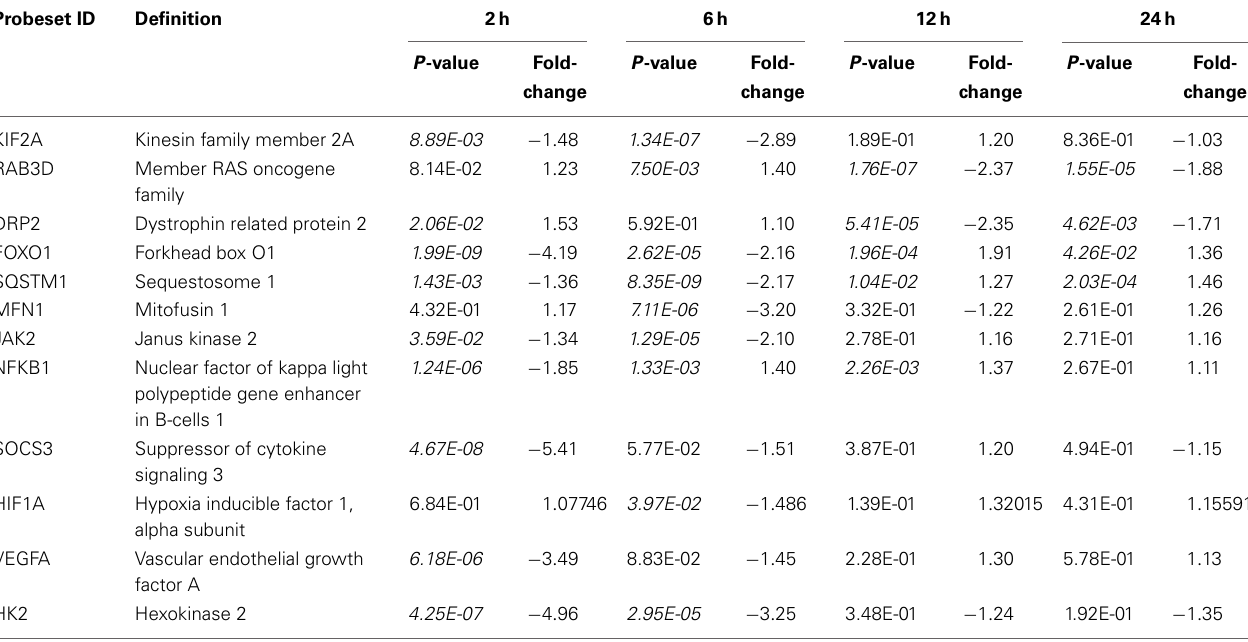
Table 1 | Selected genes with expression changes passing the filter of fold change > 2.0 and FDR < 0.05 in at least one time point for Fasudil-treated compared with untreated